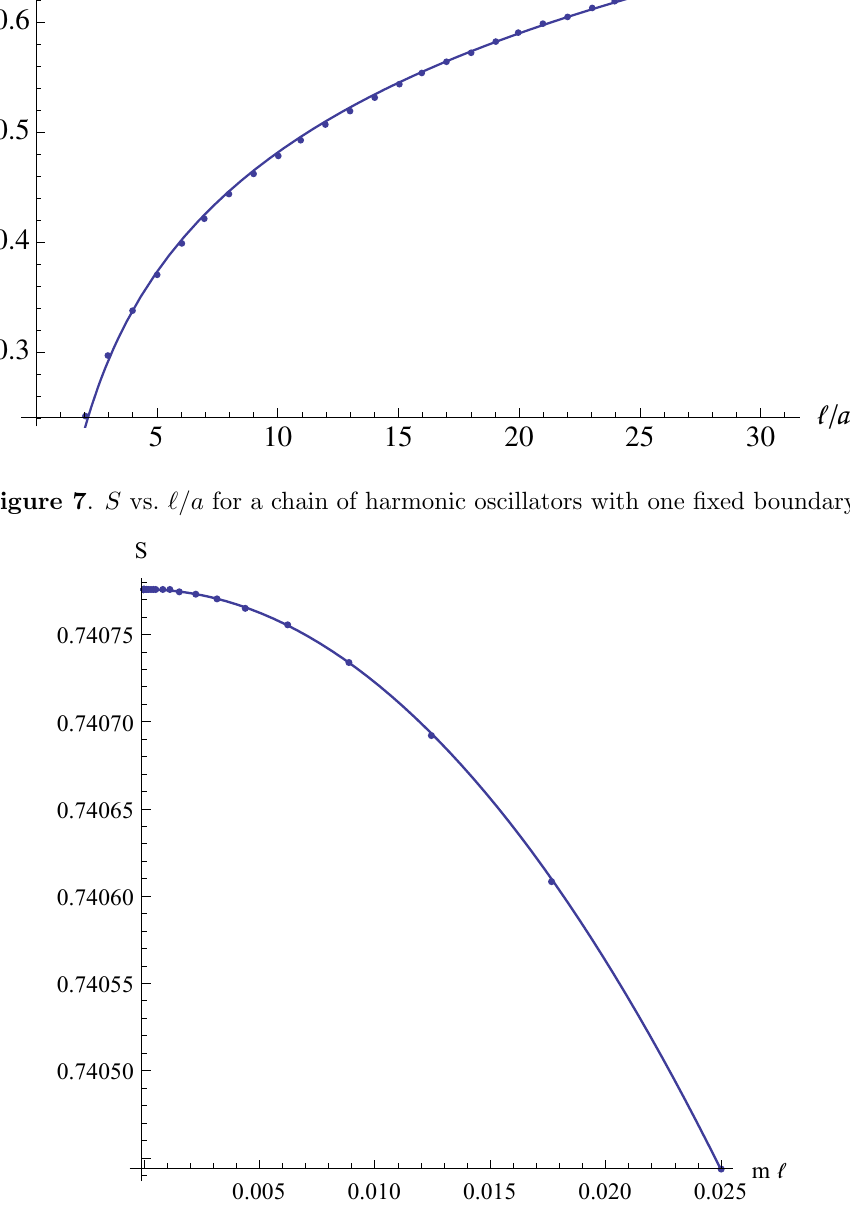
Figure 8 . S vs. m‘ for a subchain of 50 harmonic oscillators within a longer chain of 500 oscillators with one (cid:12)xed